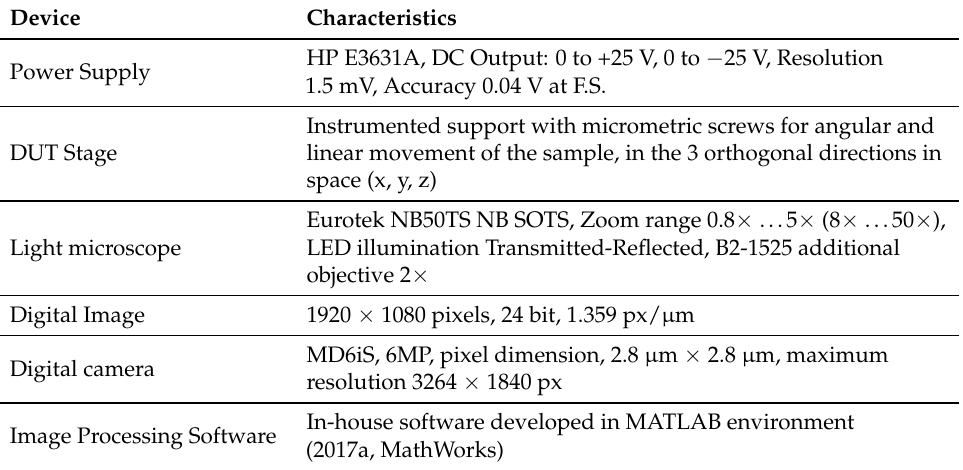
Table 2. Light Trinocular Microscope (LTM) experimental setup (DUT, micropositioner, probes and PC as in Table